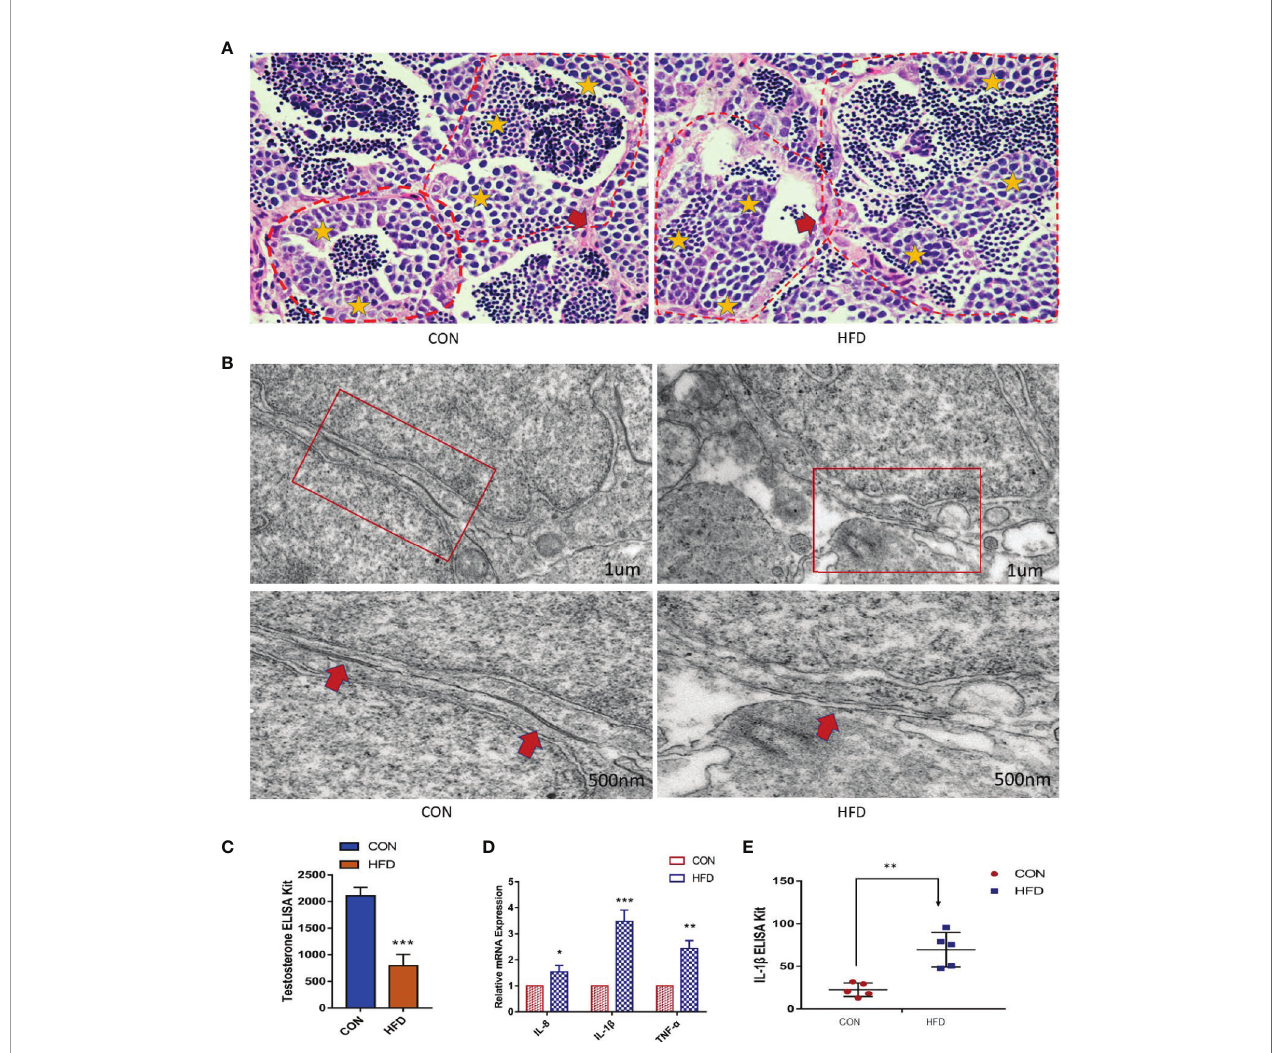
FIGURE 3 | Obesity causes the destruction of zebra fi sh BTB structure and testicular in fl ammation. (A) Testicular HE staining in the control and obese groups. Yellow stars indicate sperm vesicles of the same type of spermatogenic cells in the zebra fi sh testis, and the red arrow indicates the interstitial part. Obviously, the zebra fi sh spermatogenic cells were disorderly arranged, and the interstitium was thickened. (B) Ultrastructure of zebra fi sh BTB. Red boxes indicate connections between Sertoli cells and germ cells in zebra fi sh testis. In the enlarged image, the BTB structure of the obese group is damaged, as shown by the red arrow. (C) Detection of testosterone in the blood. The testosterone level of the obese group was markedly decreased ( P < 0.001). (D) Effects of ODP exposure on the mRNA levels of tnf- a , il-1 b , and il-8 in zebra fi sh testis. (E) Detection of IL-1 b expression in the blood by ELISA. Data represent mean ± SME (n = 5). The asterisk represents a statistically signi fi cant difference when compared with the corresponding controls; *, ** and *** at P < 0.05, P < 0.01 and P < 0.001,